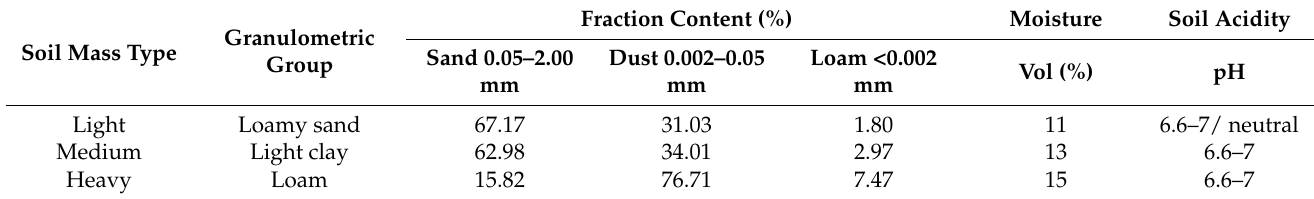
Table 2. The testing parameters.